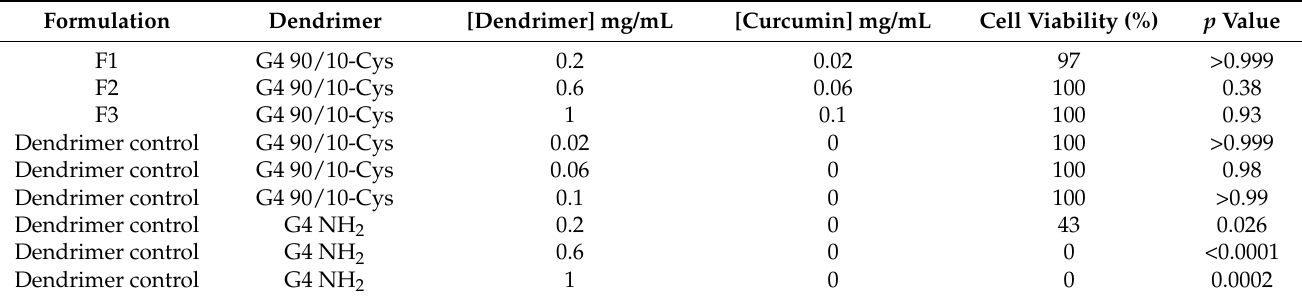
Figure 10. Viability of GL261 and non-cancerous mouse MSCs after 24 h treatment with G4 90/10- Cys, G4 90/10-Cys-Cur, and G4 NH 2 . For GL261, cell viability was not lost at any dose, and was significantly increased at the higher two doses: G4 90/10-Cys; D = 0.02 mg/mL, p = 0.974, D = 0.06 mg/mL, p = 0.0009, D = 1.0 mg/mL p = 0.0001. For G4 90/10-Cys-Cur p < 0.0001 for all three doses. For the cell treated with NH 2 , cell viability was significantly lost at every dose; D = 0.02 mg/mL, p = 0.0038, D = 0.06 mg/mL, p = 0.0001, D = 1.0 mg/mL, p = 0.0001. * p < 0.05. Table 7. Effect of F1, F2 and F3 on Mouse MSC control